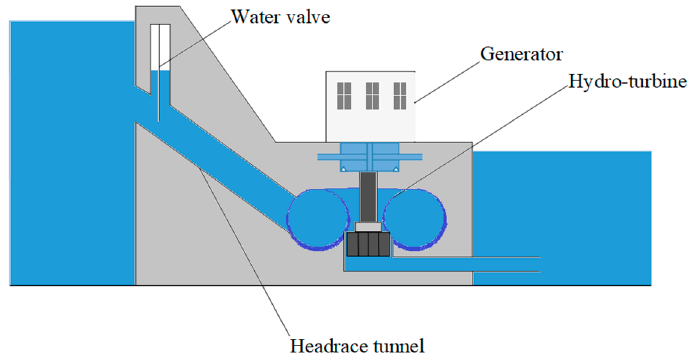
Figure 1. General schematic diagram of the hydropower system.